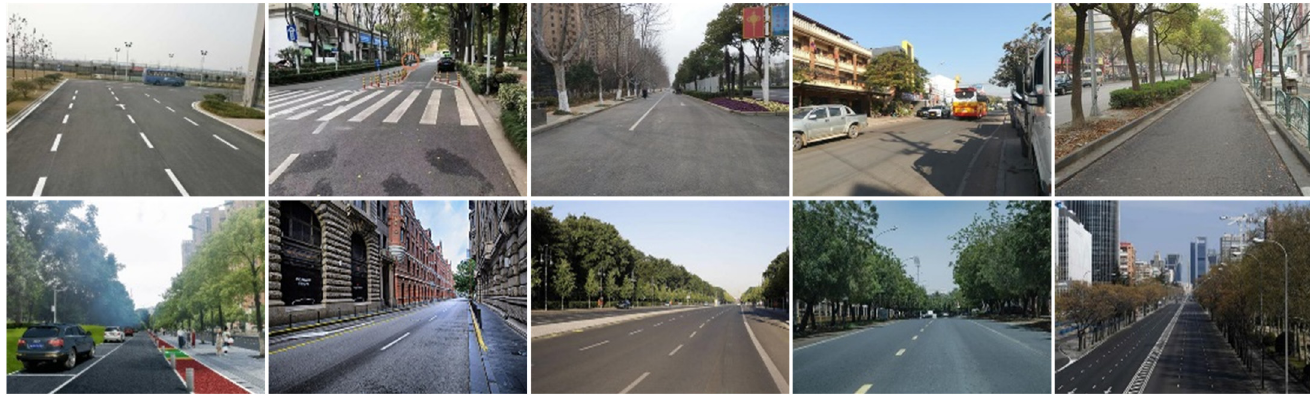
Figure 7. Images of urban streets without floods.